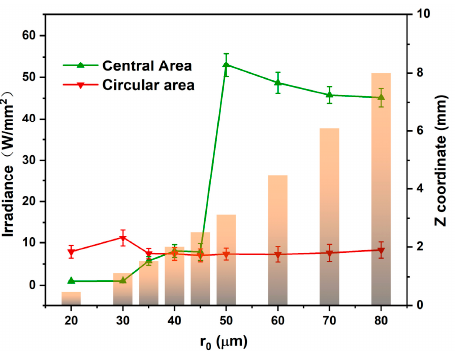
7 of 12 Figure 6. Simulation of AFZP with 𝑅 as 1.6 mm and 𝑟 (cid:2868) as 80 μ m: ( a ) annular beam in the focal plane; ( b ) energy distribution in the focal plane. In laser processing, it is usually necessary to obtain an annular beam of a specified radius R. Therefore, for an annular beam with an arbitrary radius R, it is crucial to elimi- nate the central bright spot. As can be seen from the above analysis, the central bright spot can be avoided by focusing the AFZP on the projection area of the circular hole. The posi- tion of the focusing ring on the Z -axis can be realized by adjusting the radius of the circular